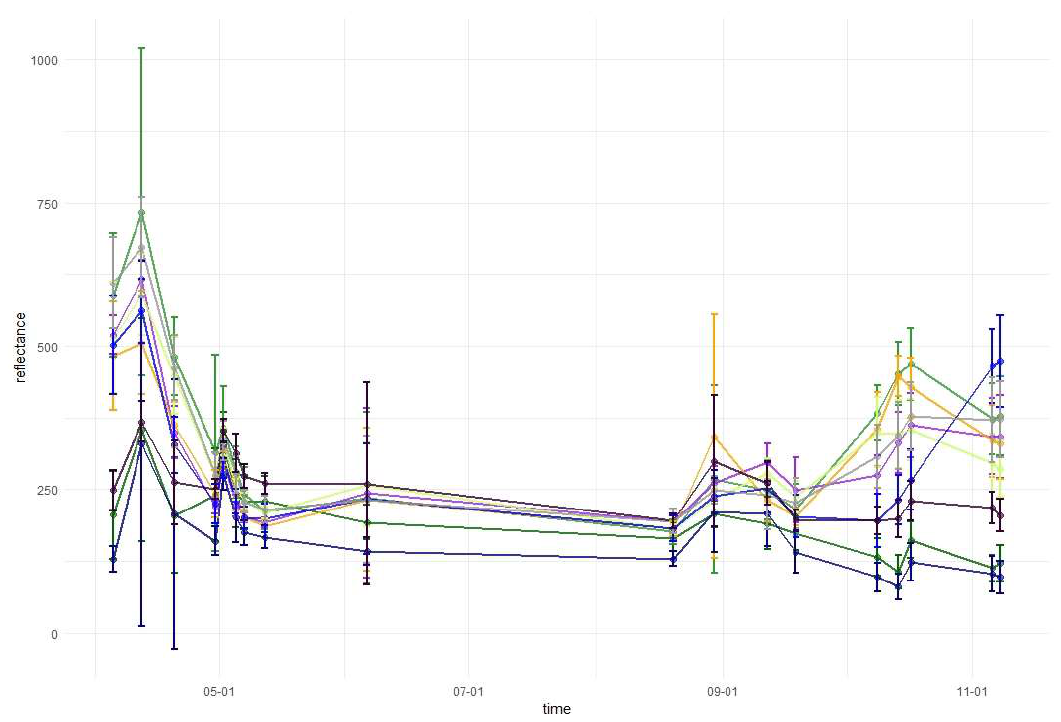
Figure A3. Mean and standard deviation values of reflectance in the visible red band.